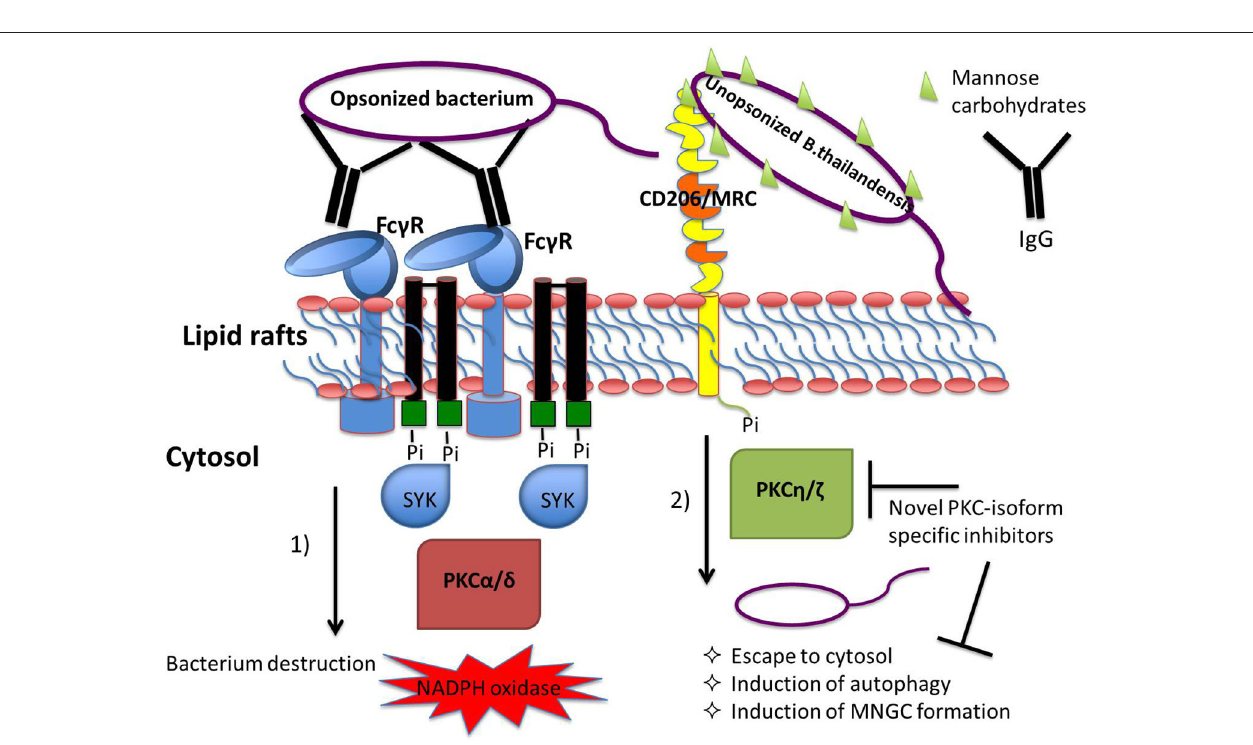
FIGURE 7 | Coating of bacteria with opsonin determines receptor usage and the involvement of protein kinase C (PKC) isoforms in the regulation of phagocytosis-associated cell responses. Immunoglobulin G-opsonized bacteria triggers Fc γ Rs-mediated phagocytosis engaging classical PKC isoform signaling pathways leading to pro-inflammatory cell responses, including the respiratory burst leading to efficient killing of bacteria within the lysosomes (Breton and Descoteaux, 2000; Dekker et al., 2000; Sudan et al., 2012 ). Interaction of bacterial glycoproteins with the host cell mannose receptor C-type 1, MRC1, stimulates signaling pathways regulated by the Ca 2 + -independent PKC isoforms resulting in escape of bacteria from the phagosome into the cytosol. Our hypothesis is that PKC inhibitors with selectivity to the novel, Ca 2 + -independent isoforms have the potential to act as host-directed antimicrobials blocking pathogen escape from phagosome